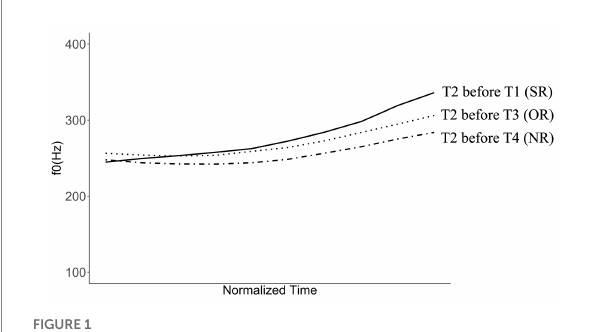
FIGURE 1 Mean f0 realization of T2 in three tonal coarticulation conditions averaged across five items in each condition. Solid line indicates the mean f0 of T2 before T1 (i.e., the SR condition), dotted line for T2 before T3 (i.e., the OR condition), dash-dot line for T2 before T4 (i.e., the NR condition). Normalized time.